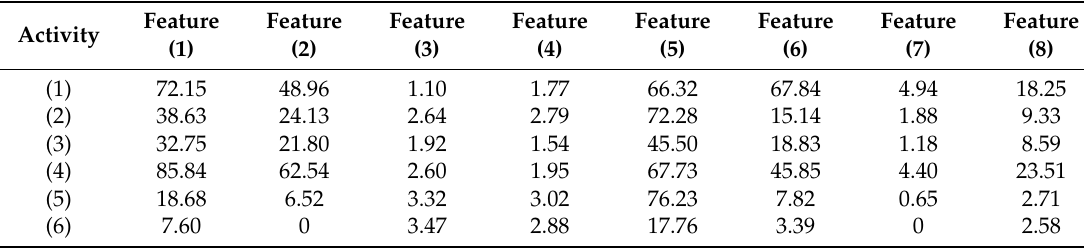
Table 1. Mean values of the eight selected